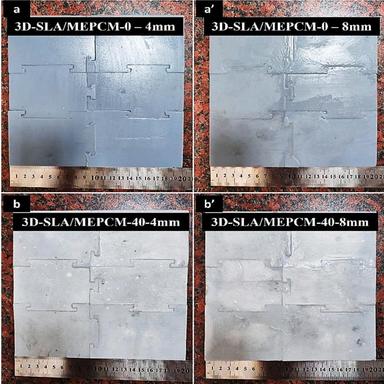
Macro view of six assembled parts printed for thermal tests; (a and a') 3D-SLA/MEPCM-0 for 4 mm and 8 mm, respectively, (b and b') 3D-SLA/MEPCM-40 for 4 mm and 8 mm, respectively.